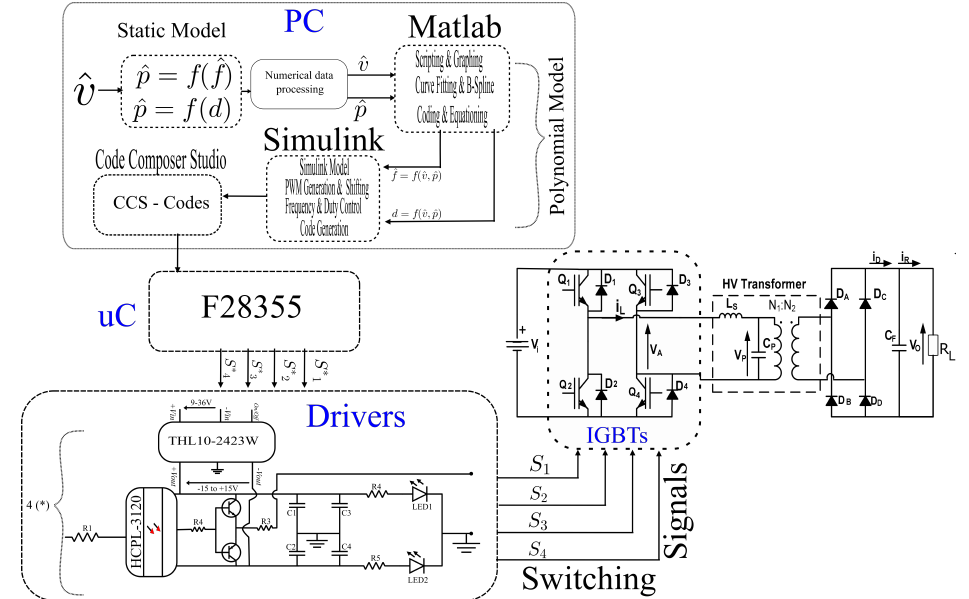
Figure 14. Illustration of the complete model of the practical implementation.